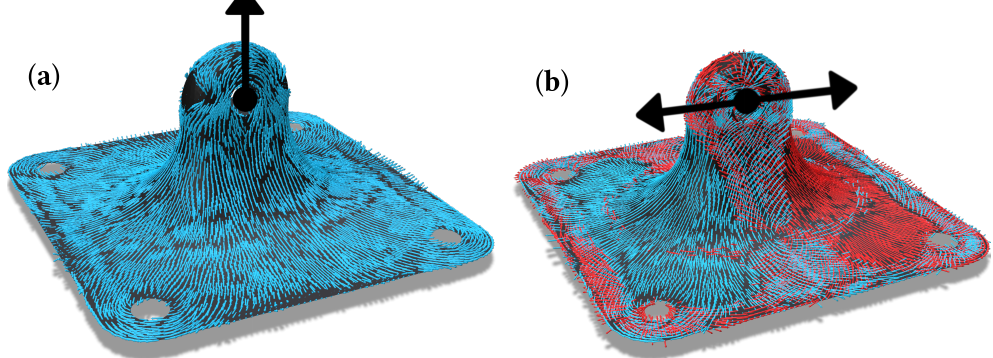
Figure 6. FEA with the load cases and the maximum principle directions. ( a ) Load case Y. ( b ) Load case